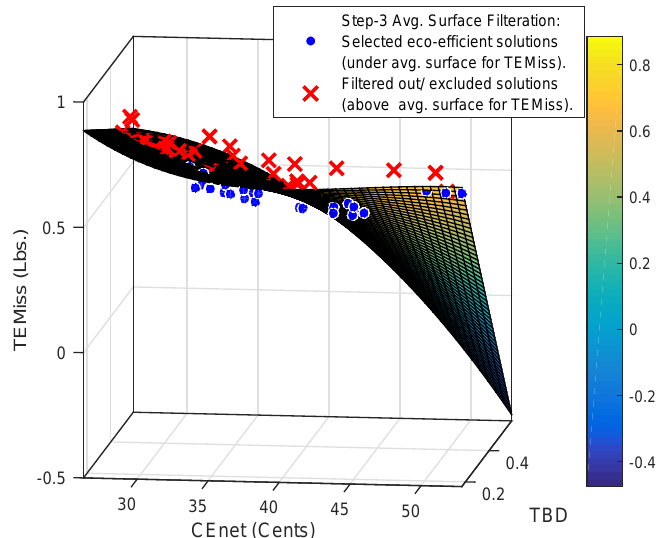
Figure 17. Eco-efficient solutions selected using average surface filtration based on Algorithm 2